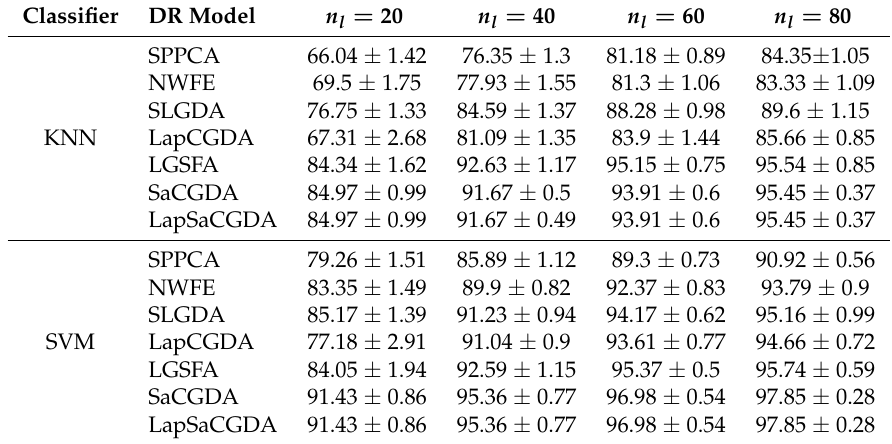
Table 8. Classification results with different amounts of training data on the Indian pines data (OA ± STD